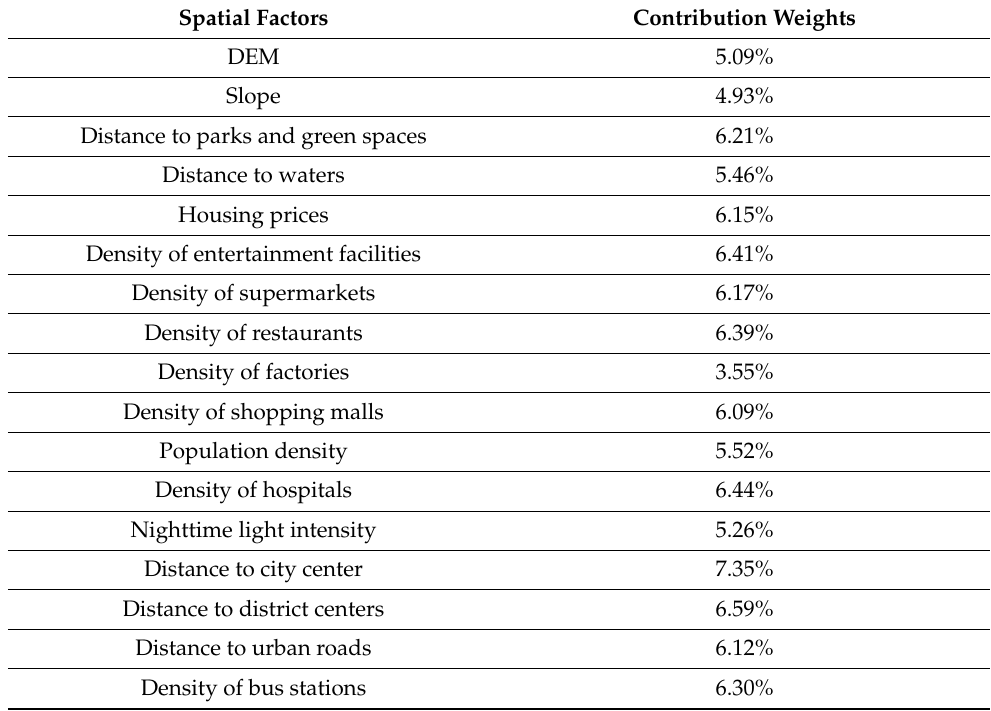
Table 5. Contribution weights of spatial factors on buildings’ FAR. Spatial